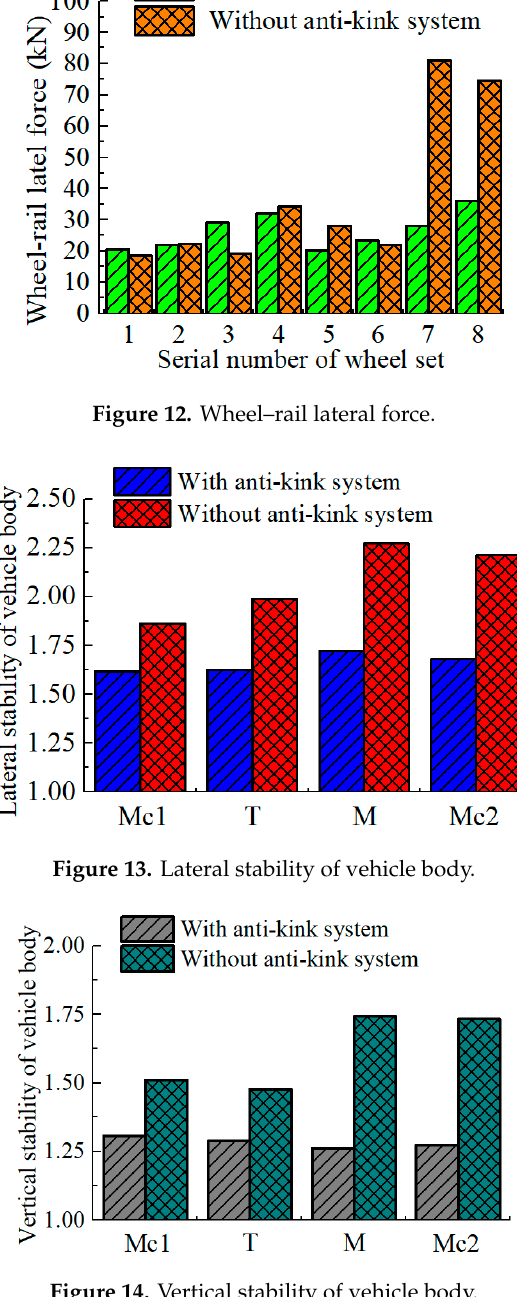
Figure 12. Wheel–rail lateral force.